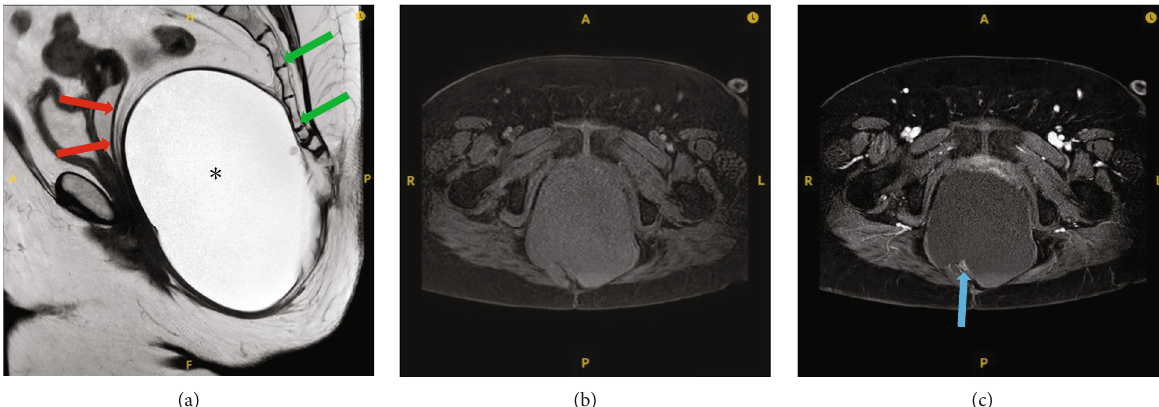
Figure 1: Pelvic MRI of the tumor showing a large retrorectal cystic mass with solid mural nodule. A sagittal T2 weighted pelvic MRI (a) demonstrated a large predominantly cystic mass ( ∗ ) which is anterior to the sacrum and coccyx (green arrow) and posterior to the rectum (red arrow). An unenhanced fat suppressed T1 weighted axial image (b) and a gadolinium enhanced fat suppressed T1 weighted axial image (c) demonstrated an enhancing nodule (blue arrow) in the posterior portion of the